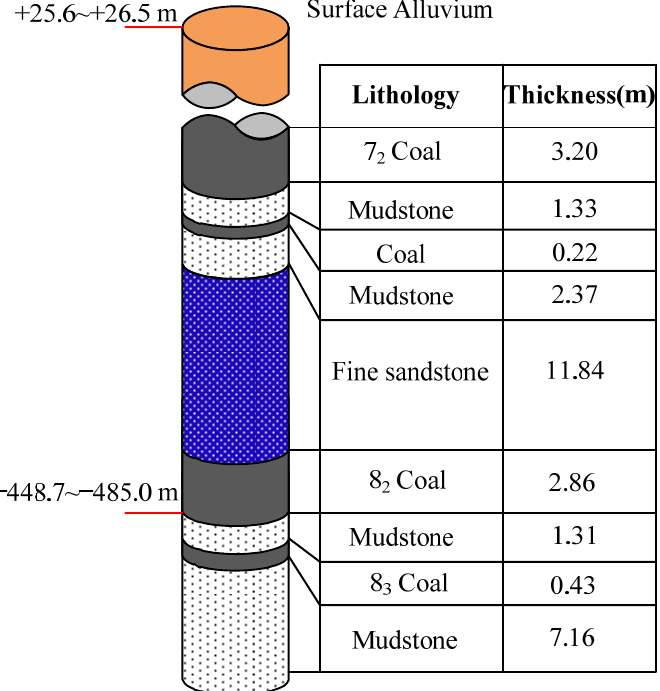
Figure 9. The stratigraphic column of the 8 2 24-machine roadway in the XT Coal